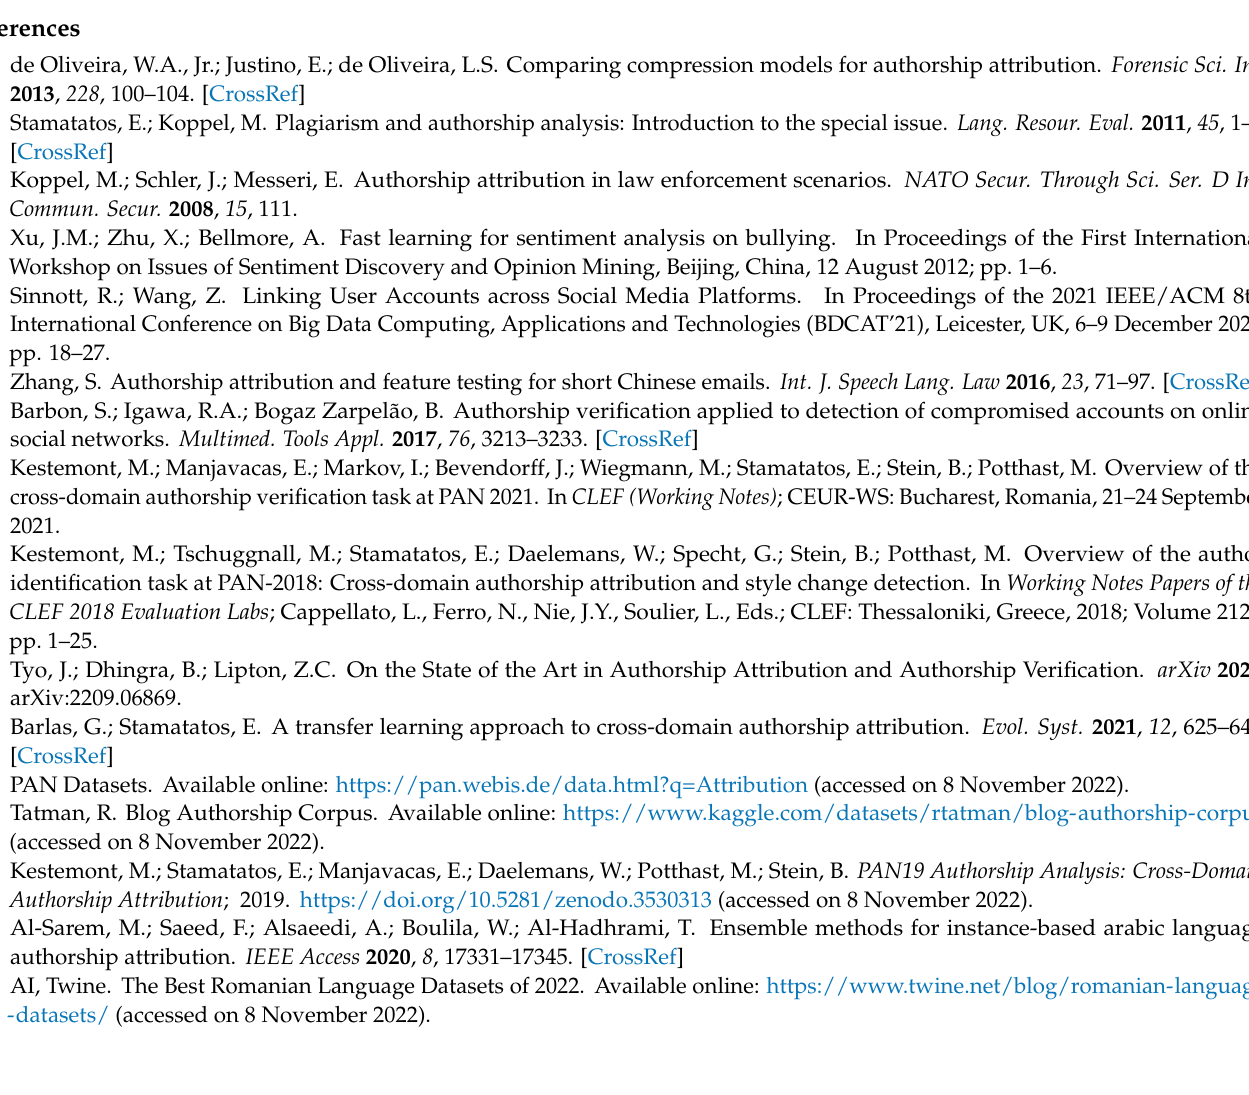
Figure A7. DT results on the considered datasets. In total, 30 runs are performed with the cases parameter (introduced by the − m option) varying from 1 to 30. The percentage of incorrectly classified data is